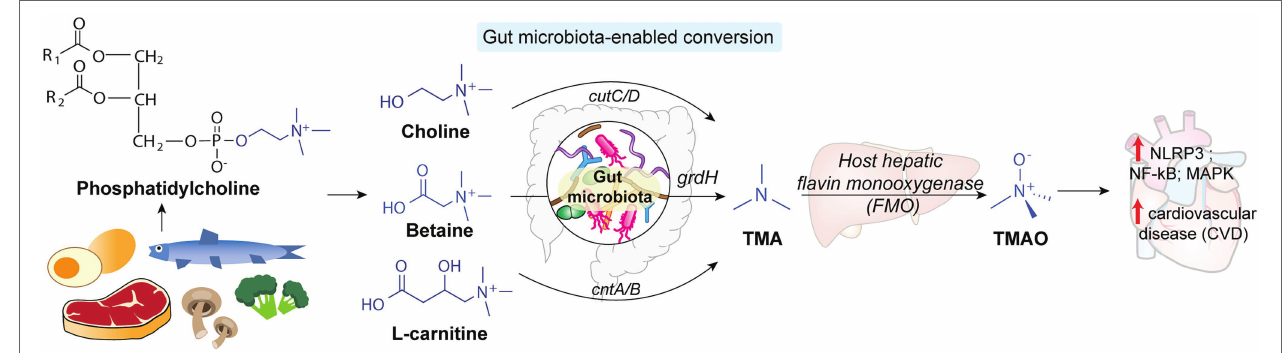
FIGURE 6 | The gut microbiota is involved in converting dietary phosphatidylcholine into TMA, which is transported to the host liver and converted to TMAO that is strongly associated with cardiovascular disease in the